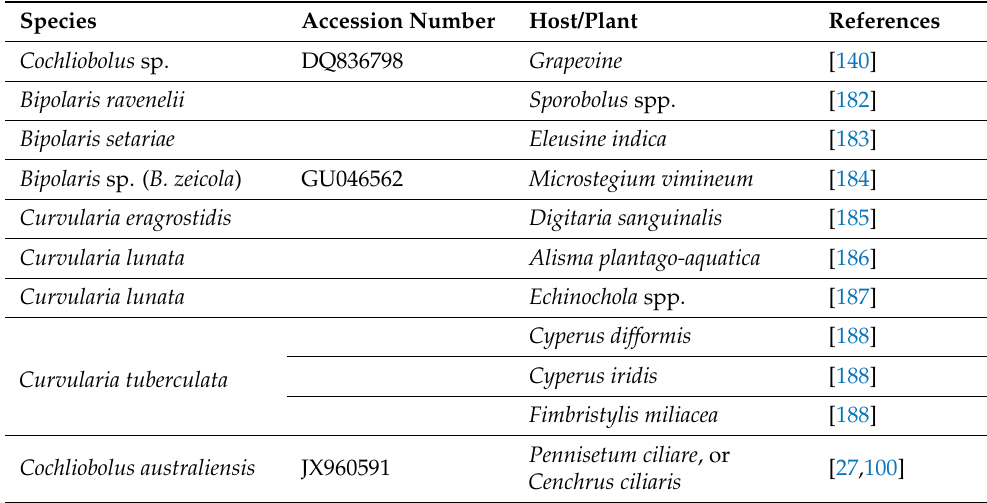
Table 6. Cochliobolus , Bipolaris , and Curvularia species function as biological control agents.